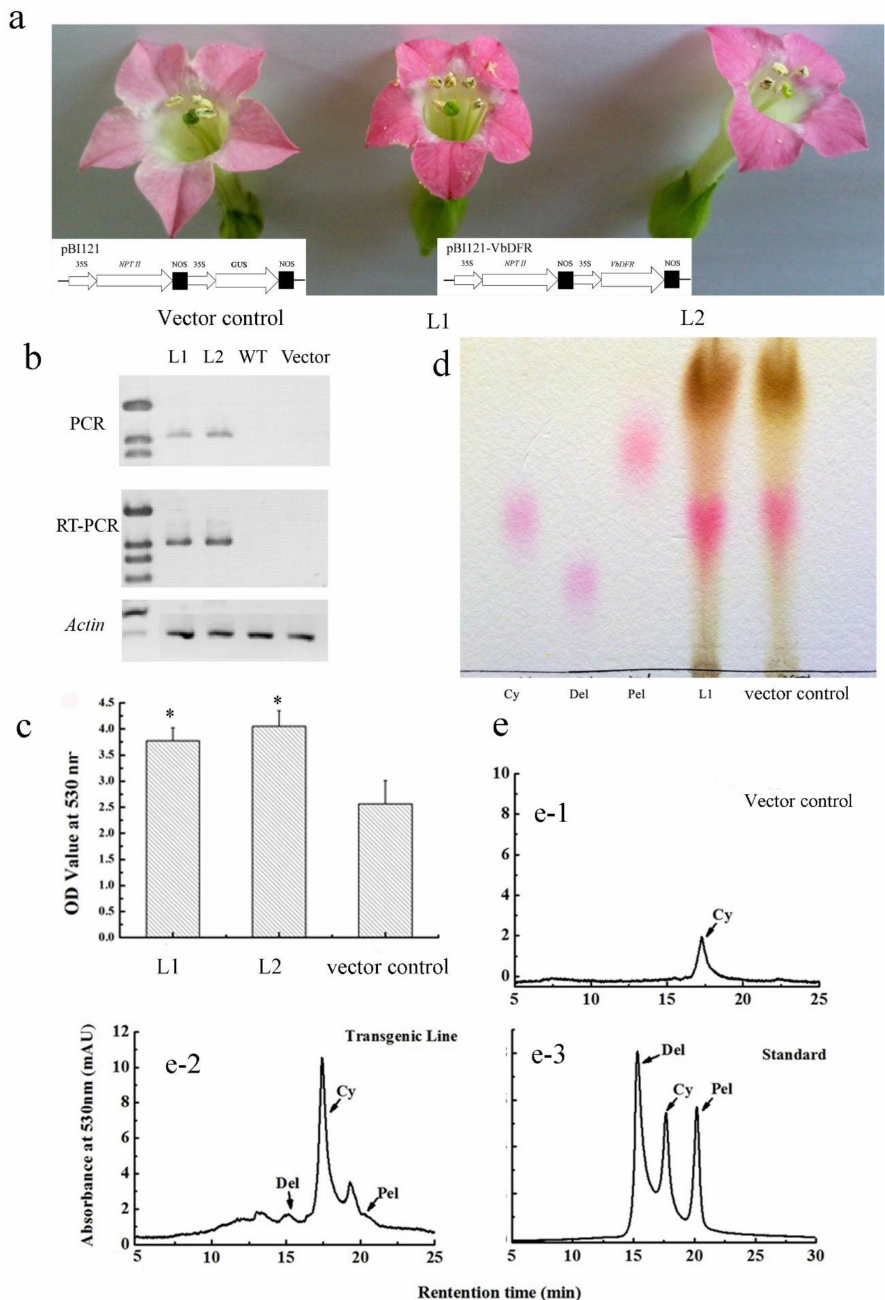
Figure 5. Increase of anthocyanins in transgenic tobacco flowers overexpressing VbDFR . ( a ) cassettes of pBI121 and pBI121-VbDFR vectors show VbDFR controlled by 35S promoter for overexpression, and red pigmentation was enhanced in flowers of two VbDFR transgenic tobacco lines (L1 and L2) compared with vector control flower; ( b ) images show fragments amplified by genomic DNA-based PCR and RT-PCR; ( c ) absorbance values for anthocyanin extracts were significantly higher from flowers of VbDFR transgenic tobacco lines (L1 and L2) than from vector control flowers; ( d ) TLC profiles show anthocyanidins from the butanol:HCl hydrolysis of anthocyanins extracts from transgenic tobacco line (L1) and vector control plants; ( e ) HPLC profiles show anthocyanidins from butanol:HCl hydrolysis of anthocyanins extracted from transgenic tobacco line (e-1) and vector control (e-2) plants. e-3: authorized standards, Del: delphinidin, Cy: cyanidin, Pel: pelargonidin. * significant difference between transgenic and wild-type control